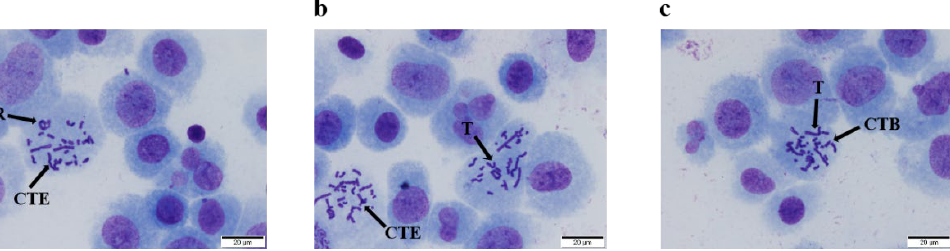
Figure 2. Types of chromosomal aberration for cell under microscope. ( a ). chromatid exchange (CTE) and ring (R); ( b ). chromatid exchange (CTE) and translocation (T); ( c ). chromatid break (CTB) and translocation (T).